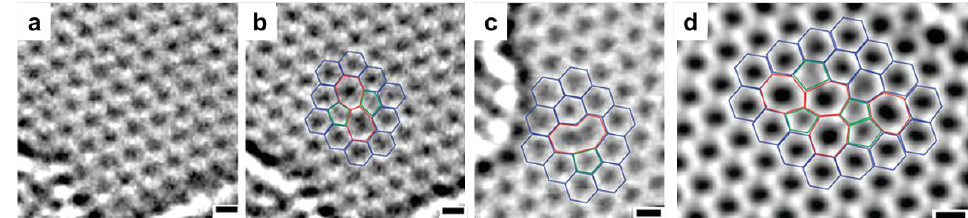
Figure 1. HRTEM images show different kinds of defects in graphene sheets. ( a ) Unperturbed lat- tice. ( b ) Stone – Wales (SW) defect with atomic configuration superimposed. This topological defect involves the rotation of carbon – carbon (C –C) bonds by π/2 causing the transformation of four hex- agons into two heptagon – pentagon pairs). ( c ) Reconstructed vacancy with the atomic configuration; a pentagon is indicated in green. ( d ) Defect image and configuration comprising four pentagons (green) and heptagons (red). The scale bar corresponds to 2 Å . Taken with permission and adapted from [2]. Copyright by ACS.